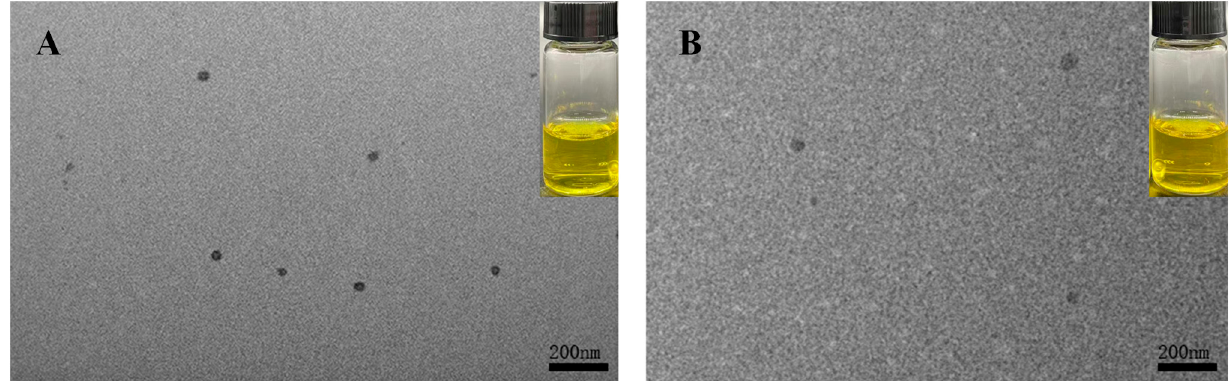
Figure 5. Transmission electron microscopy images of 7S-Cur ( A ) and 7S-150-Cur ( B ). The tube in each image shows the visual appearance of the corresponding nanocomplexes. 7S: soy β - conglycinin; 150: dextran (150 kDa); Cur: